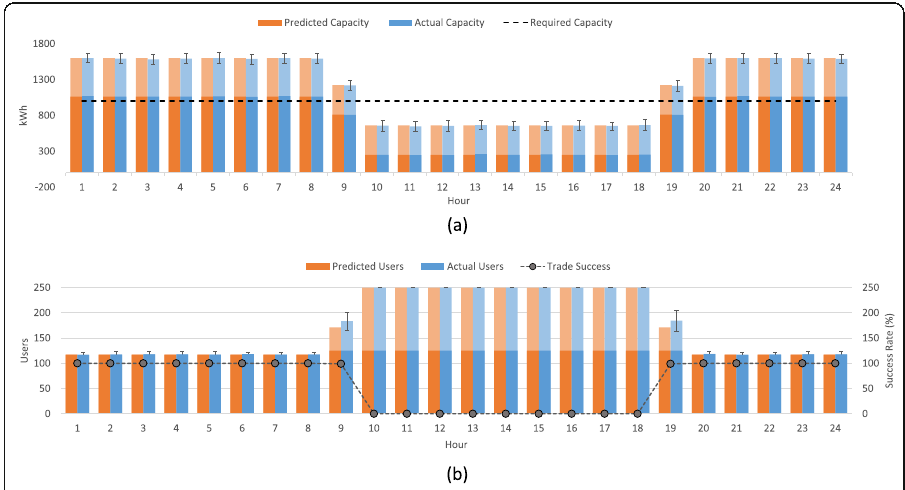
Fig. 8 Simulation results (description as for Fig. 5) after 60 trade iterations with learning enabled and user type B reliability, P (D n ) =